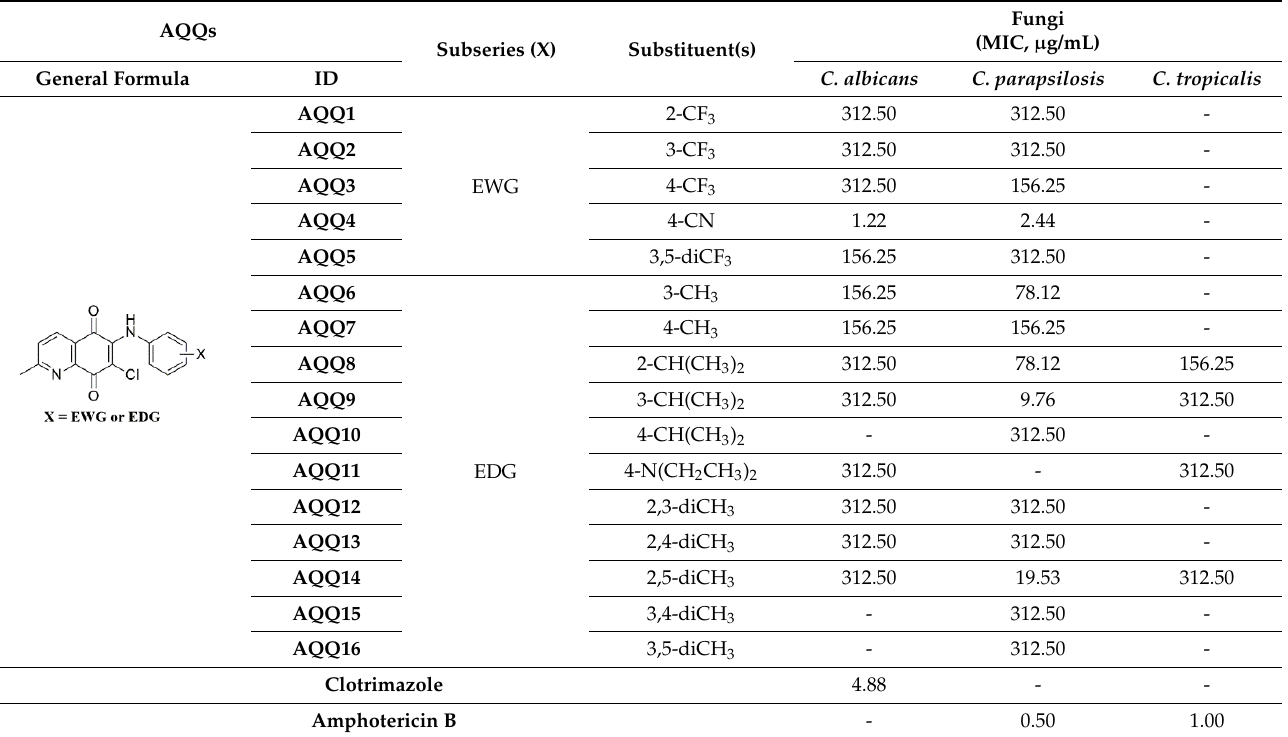
Table 3. The minimal inhibitory concentration (MIC) values of the AQQs ( AQQ1 – 16 ) for antifungal activity a